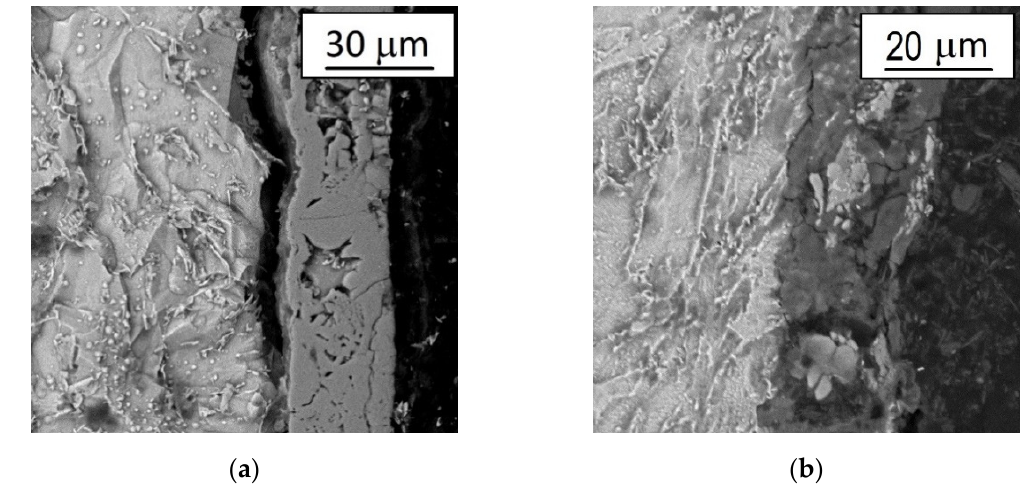
Figure 5. The microstructure of the analyzed coatings observed under the scanning microscope: ( a ) Group 1, ( b ) Group 2.